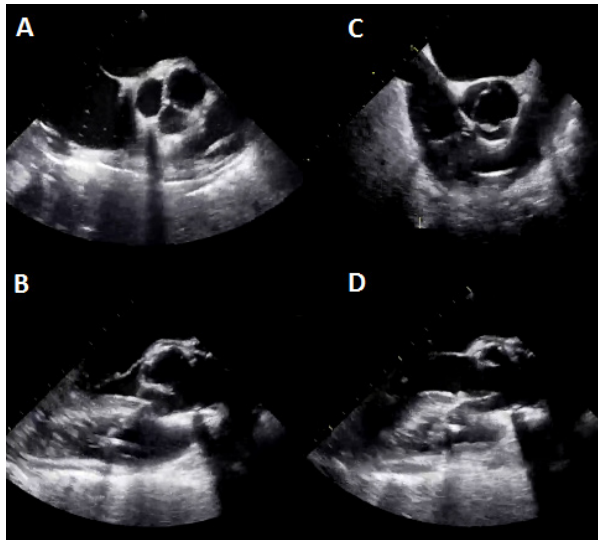
Fig. 3 – Echocardiographic pictures after the surgical procedure. A and B display adequate leaflet coaptation. C and D display the opening of the neo-aortic